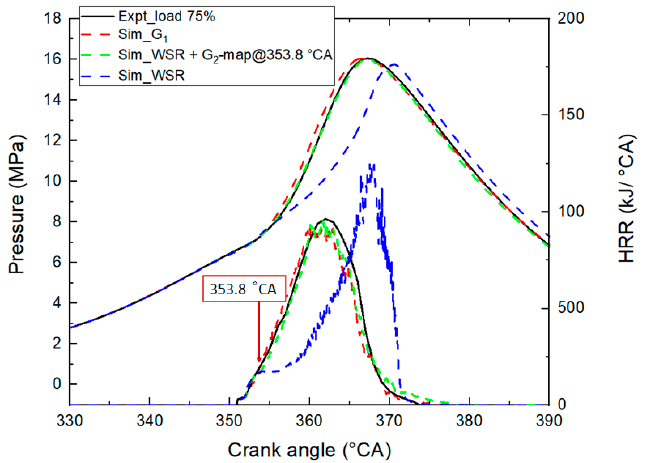
Figure 6. In-cylinder pressure and HRR of experimental and simulation results with different flame development models.